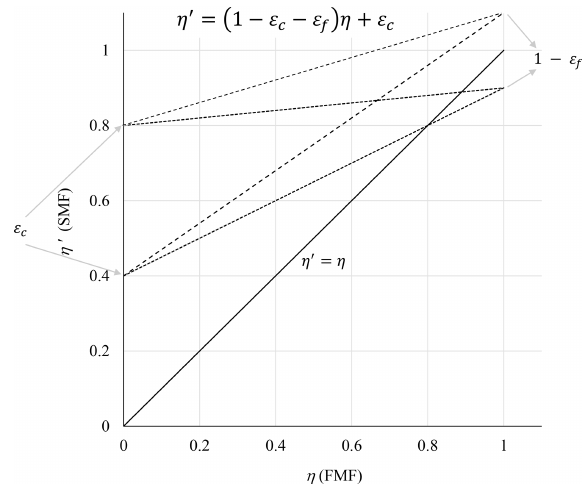
Figure 3. η (cid:48) (SMF) vs. η (FMF) lines of Eq. (7a) for three ε c values and three ε f values (0, 0.4 and 0.8 and − 0.1, 0 and 0.1, respectively). The ε c values were inspired by the range of empirical values seen in Fig. 6 (and, in the case of ε f , by the range of values, whether real or artifactual, seen in Fig.